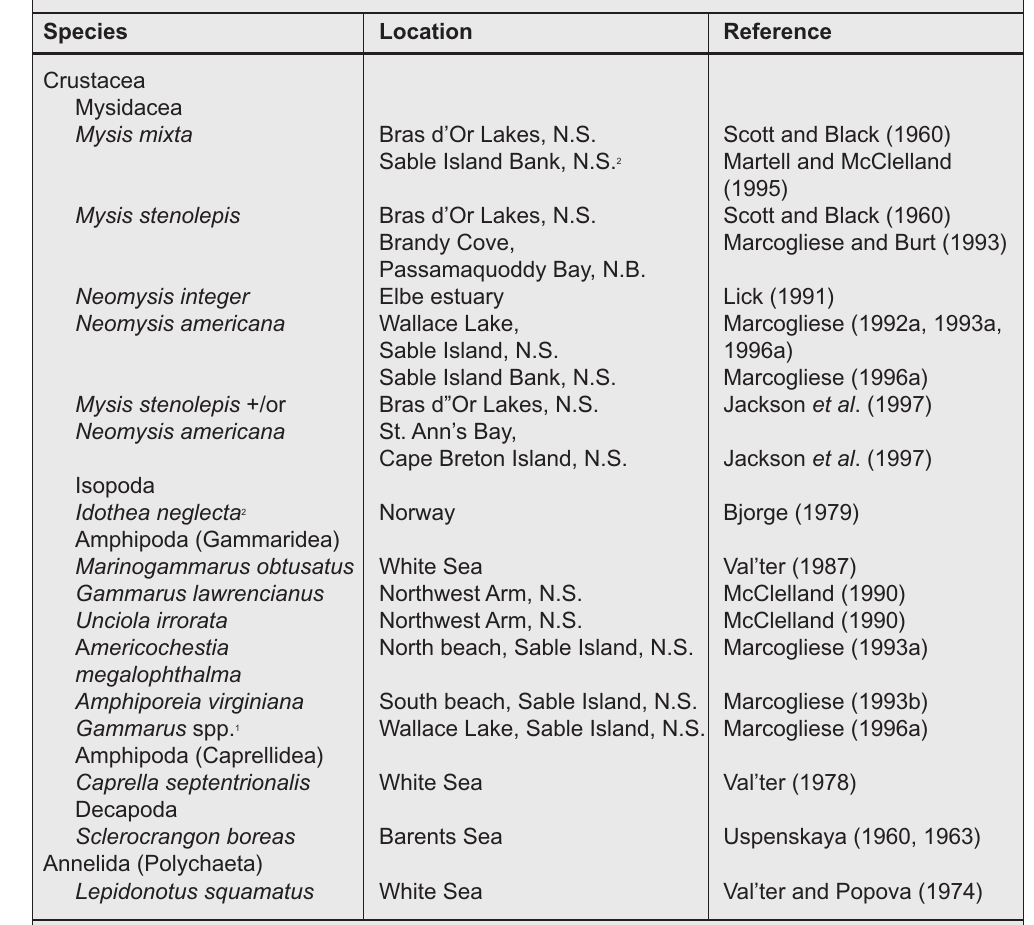
Table 2 . List of invertebrates found naturally infected with sealworm ( Pseudoterranova decipi- ens